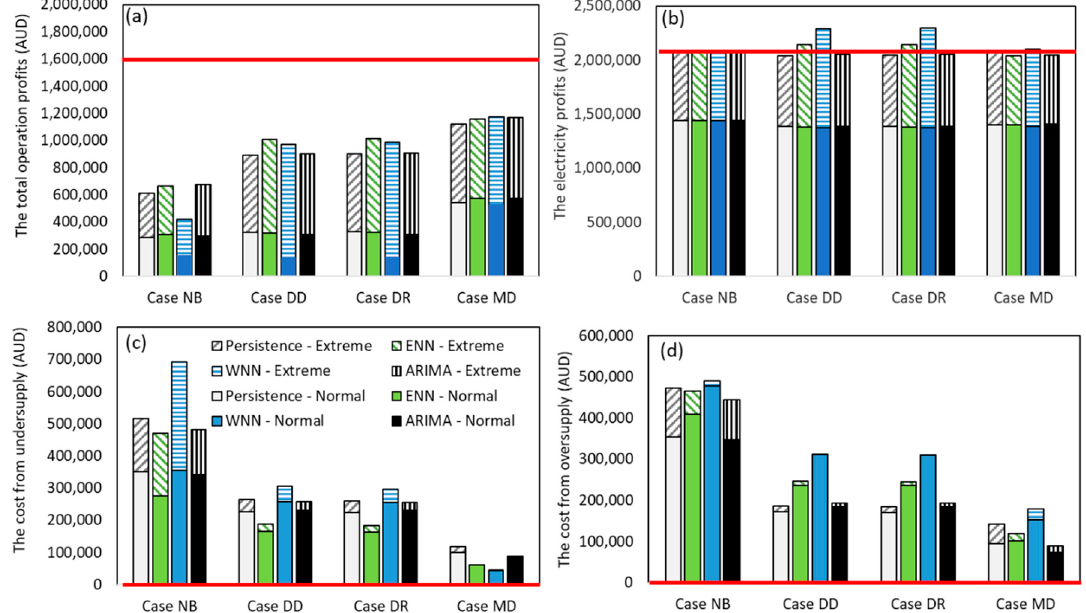
Figure 6. The comparison of optimisation results for one year, including normal and extreme days. ( a ) The total operation profits; ( b ) The electricity profits; ( c ) The cost from undersupply; ( d ) The cost from oversupply. The red line in each plot indicates the results for perfect forecasting with no battery as a reference.